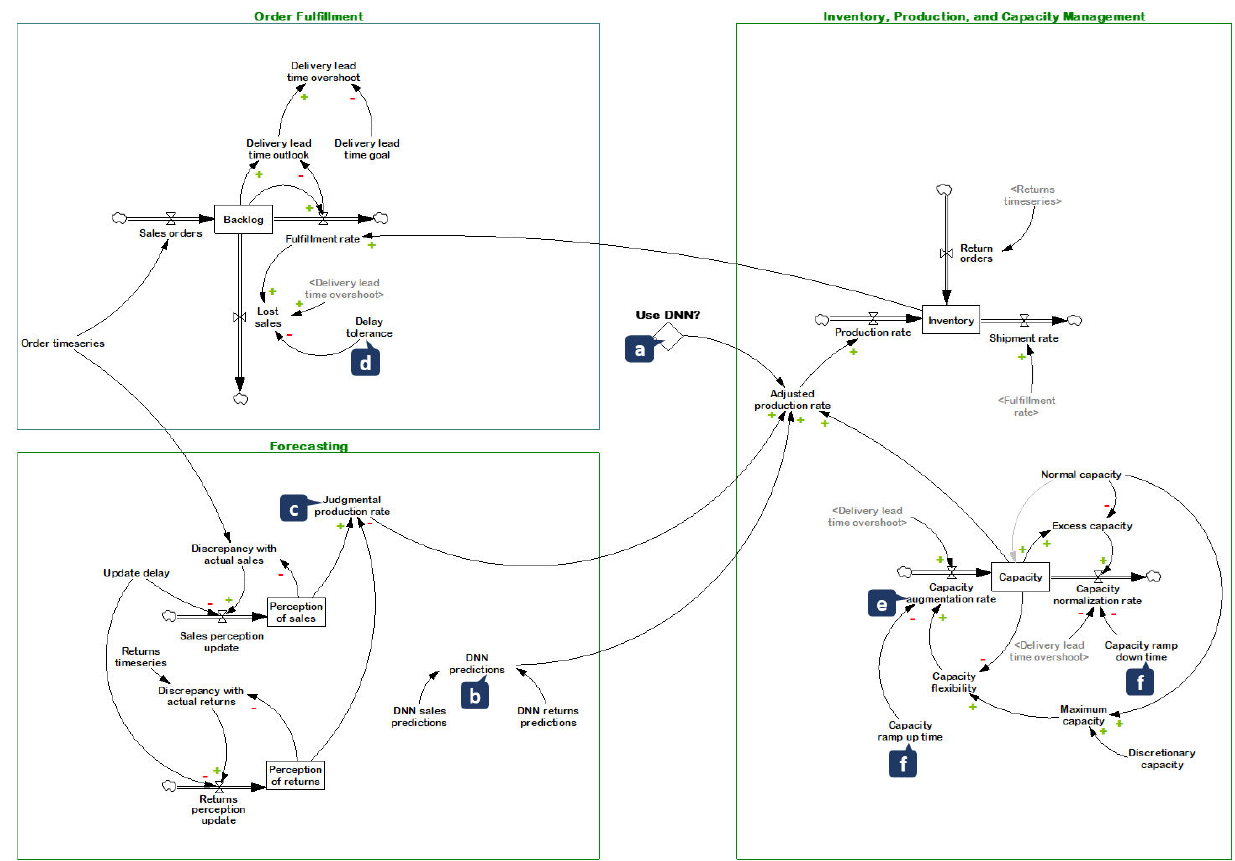
Figure 10. Whole simulation model. ( a ): Choice of forecasting procedure. ( b ): RNN forecast—a “hook” that is programmatically substituted with online predictions via PySD. ( c ): Judgmental forecast. ( d ): Delay tolerance. ( e ): Capacity adjustment under delivery pressure. ( f ): Capacity ramp-up and ramp-down